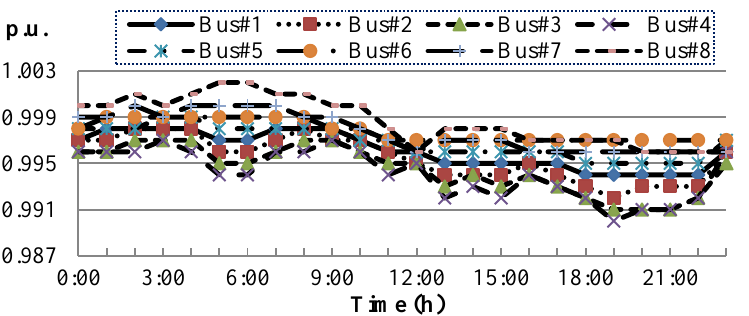
Figure 13. Numerical results of bus voltage under autonomous